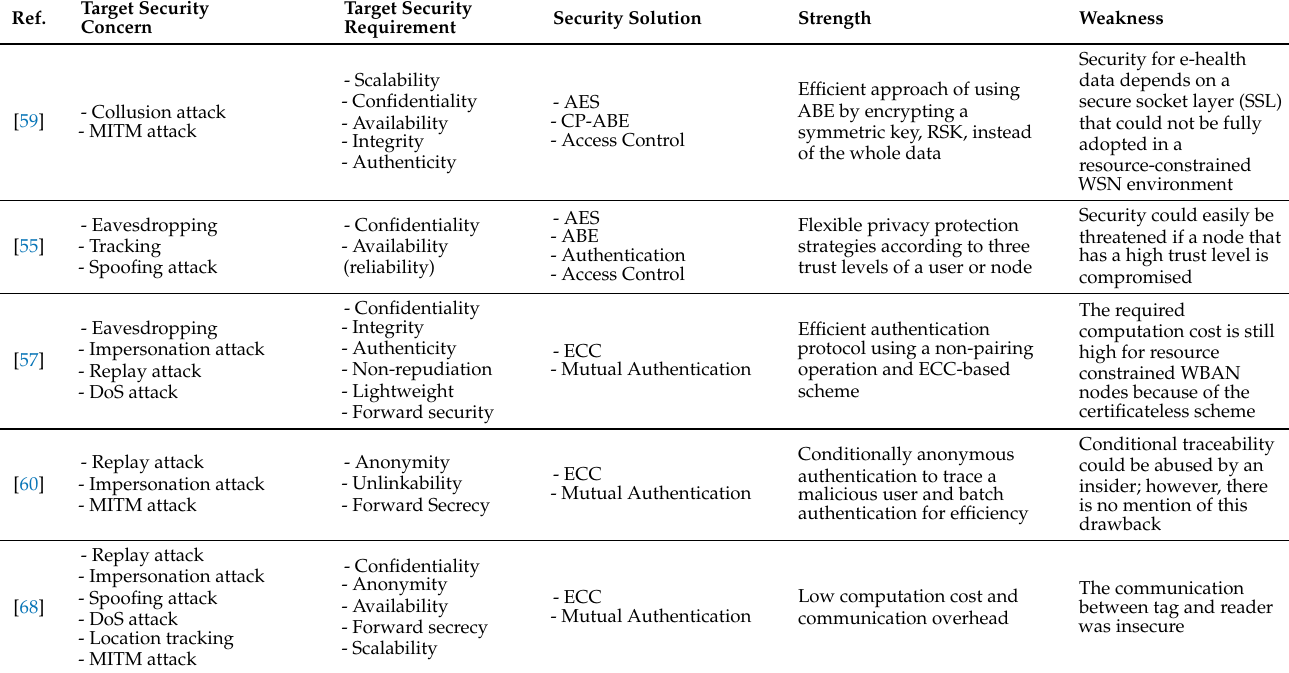
Table 5. Summary for security and privacy study analysis on medical network.